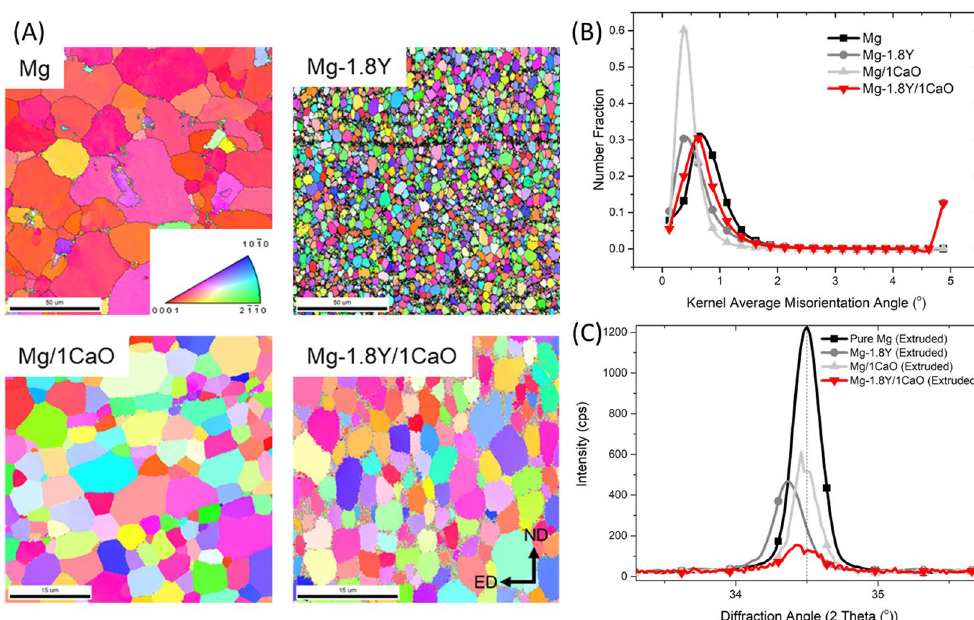
Figure 3. ( A ) Electron back-scattered diffraction patterns of the materials ( B ) Kernel Average Misorientation plots of the materials ( C ) X-ray diffraction results of the nanocomposite in comparison with its monolithic material. It must be noted that the difference in intensities correlated to the texture of the materials and is given in arbitrary units of counts per